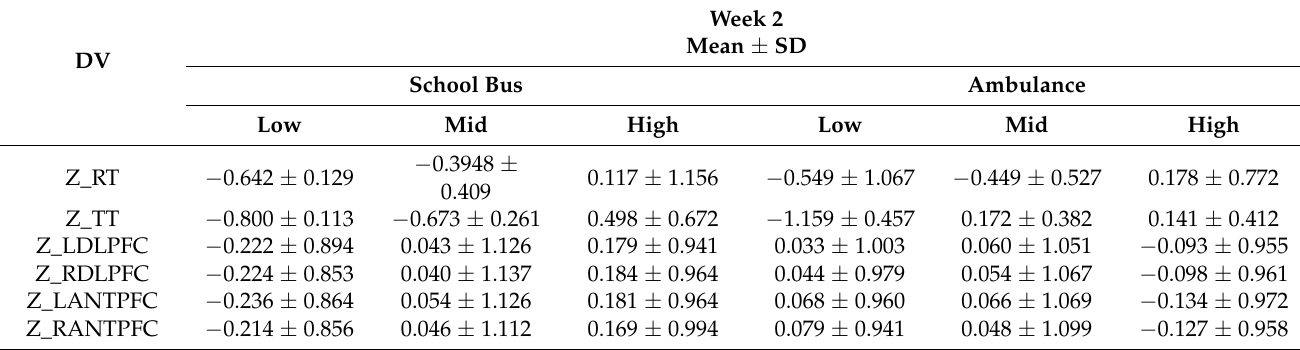
Table A3. Week 2 standardized Z scores for School Bus and Ambulance problem